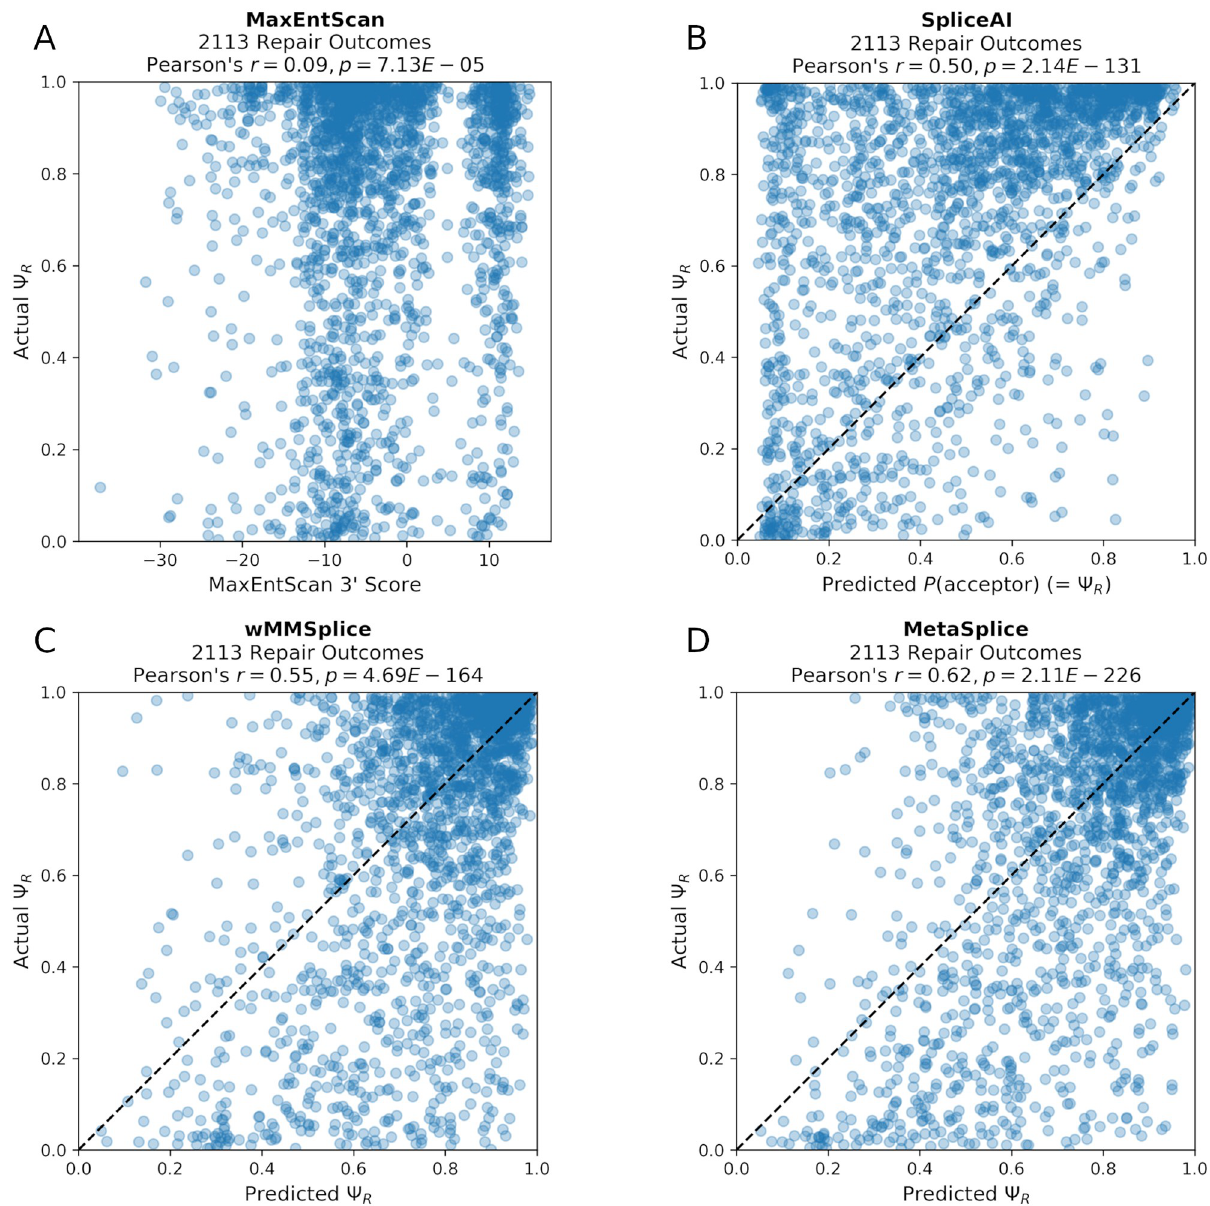
Fig 3. Actual C vs. MaxEntScan scores, SpliceAI predictions, wMMSplice cross validated predictions, and MetaSplice cross validated predictions R of C R for 2,113 repair outcomes. Each plot shows the actual C R vs. scores and predictions from various methods on 2,113 different repair outcomes vs. MaxEntScan scores ( r = 0.09). (B) Plot of the actual C vs. SpliceAI predictions ( r = 0.50). (associated with 1,063 gRNAs). (A) Plot of the actual C R R (C) Plot of the 10-fold cross validated predictions of C R from wMMSplice (mean r = 0.55). (D) Plot of the 10-fold cross validated predictions of C R from MetaSplice (mean r = 0.62). The same 10 folds were used for wMMSplice and MetaSplice.